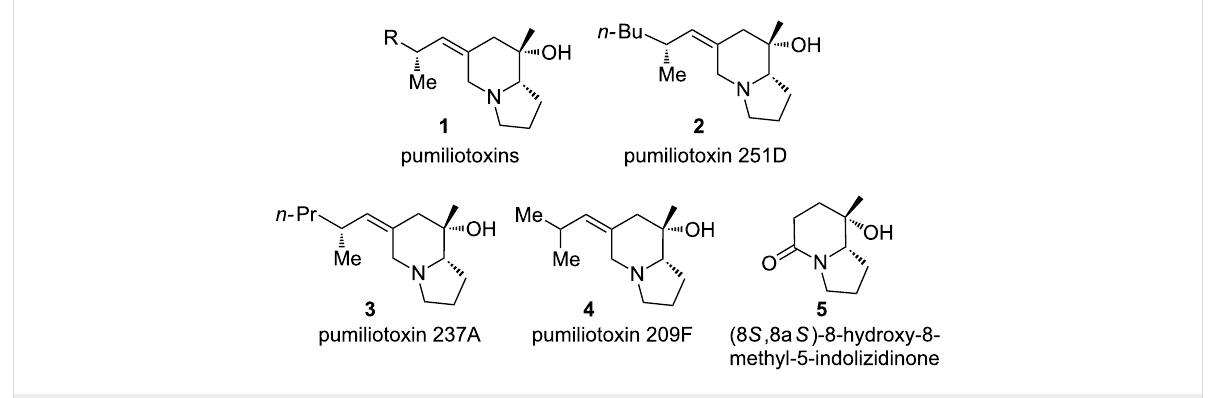
Figure 1: Structures of some pumiliotoxins and an advanced intermediate.